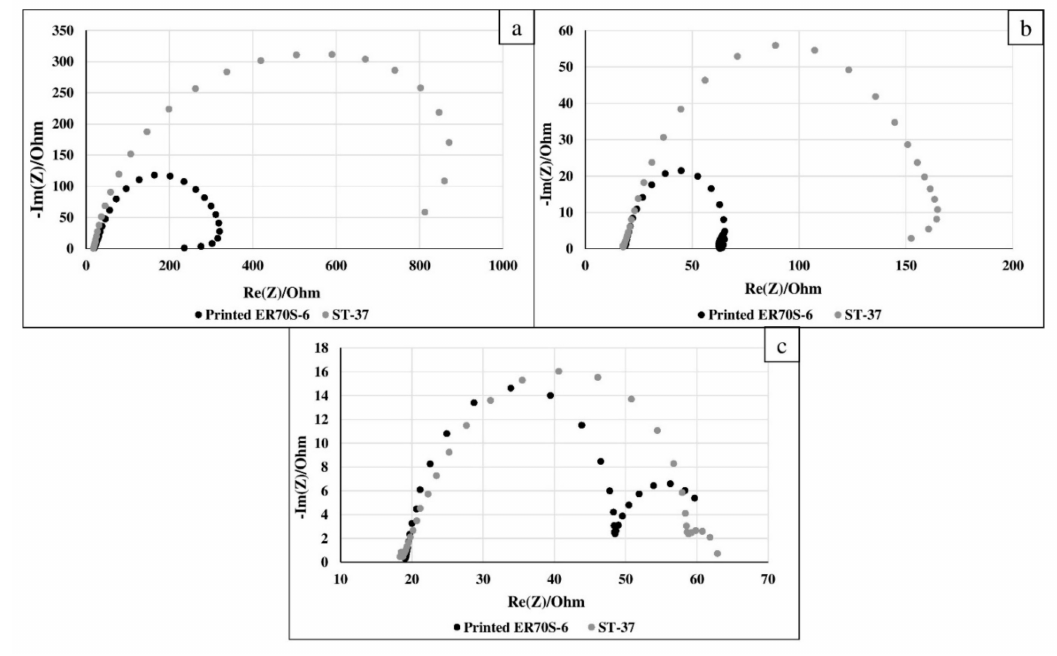
Figure 12. Nyquist diagrams of printed ER70S-6 and reference ST-37 alloys in 3.5% NaCl solution after various immersion times; ( a ) 30, ( b ) 180 and ( c ) 540 min.